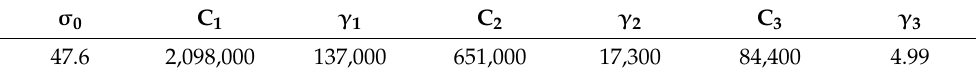
Figure 8. Results of a total strain increase at 240 °C test with 𝛥𝜀 𝑎,𝑡 = 0.05% and 𝜀 𝑎,𝑡,𝑠𝑡𝑎𝑟𝑡 = 0.05% (specimen 7.1): Material responses vs. time diagram. Table 3. Chaboche parameters for 240 ◦ C, determined at load cycle